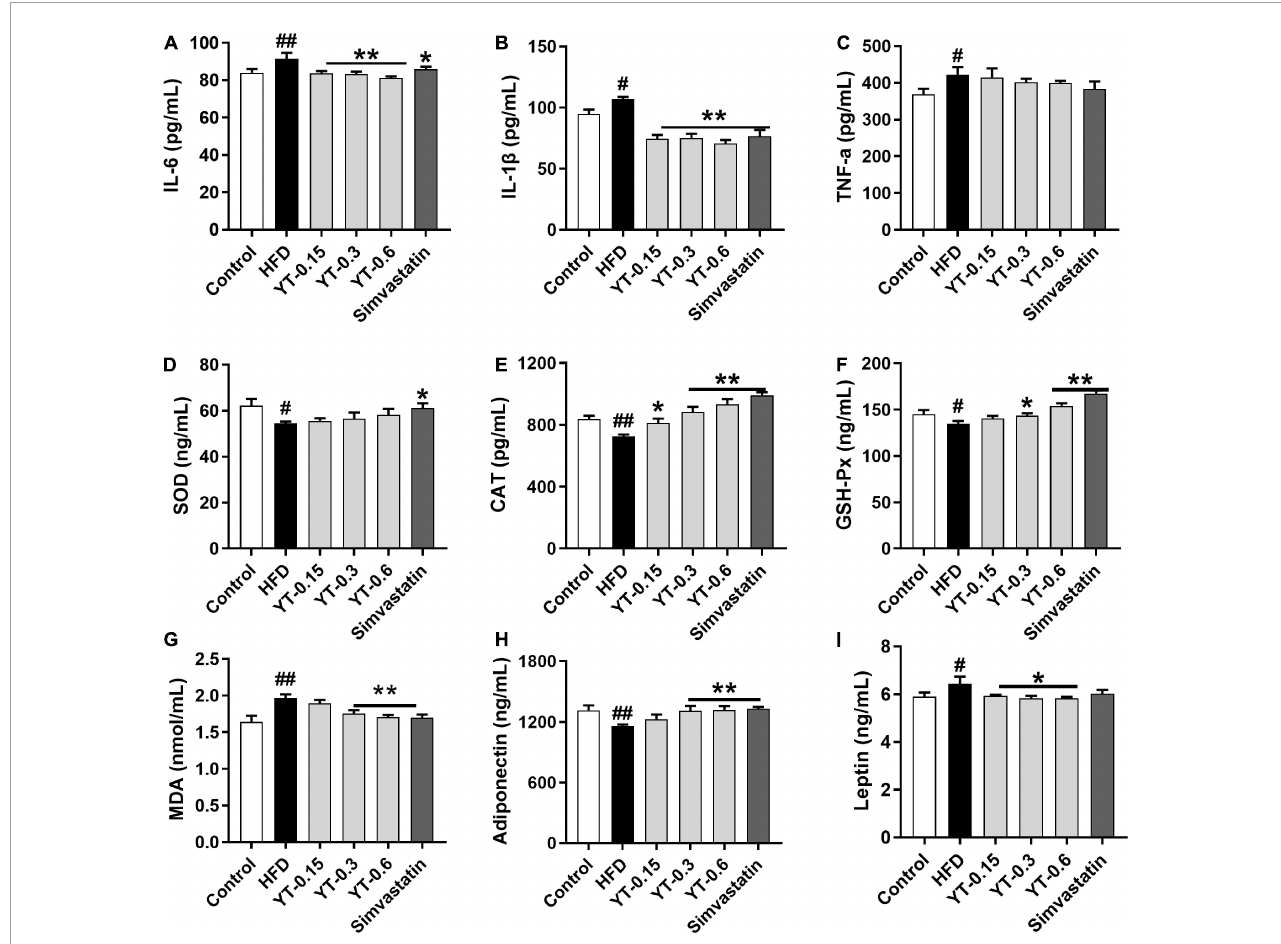
FIGURE3 Effect of YT extract on inflammation and oxidative stress. (A) IL-6, (B) IL-1 β , (C) TNF- α , (D) SOD, (E) CAT, (F) GSH-Px, (G) MDA, (H) Adiponectin, (I) Leptin. Data are presented as mean ± SEM ( n = 6). # p < 0.05 and ## p < 0.01 vs. the control group; * p < 0.05 and ** p < 0.01 vs. the HFD group.